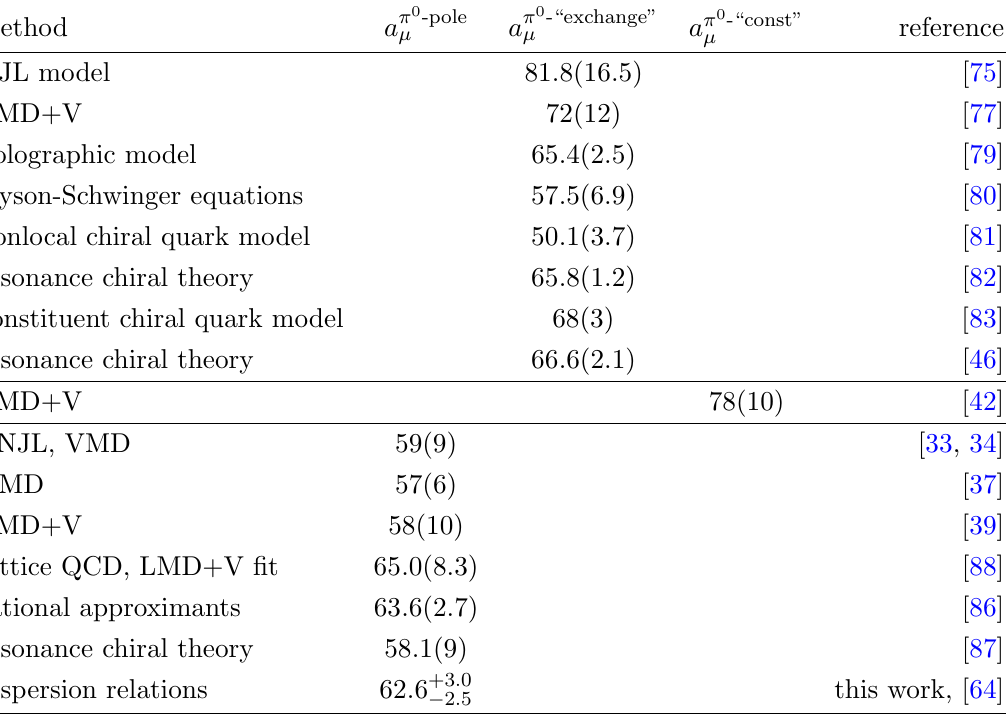
Table 3. Comparison to previous results for a (cid:25) 0 -pole . The uncertainties are reproduced as given (cid:22) in the respective publication, see main text for further discussion. For completeness, we also list works that calculate contributions involving an o(cid:11)-shell pion instead ( (cid:25) 0 -\exchange") or put one of the form factors to a constant ( (cid:25) 0 -\const"), but stress that these results either depend on the interpolator of the pion (cid:12)eld or do not correspond to the dispersively de(cid:12)ned pion pole, respectively, and therefore cannot be compared with the on-shell pion-pole